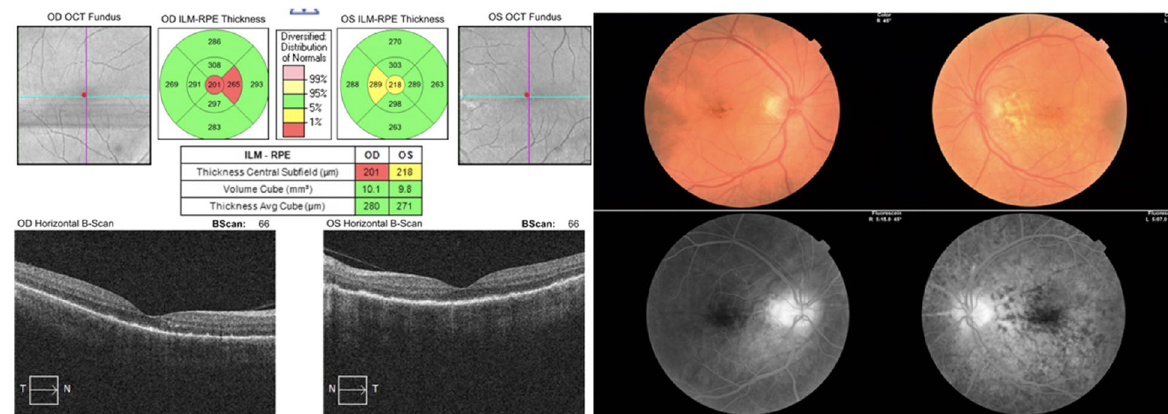
Fig. 6 16.09.2021: BCVA (0.8/0.8)